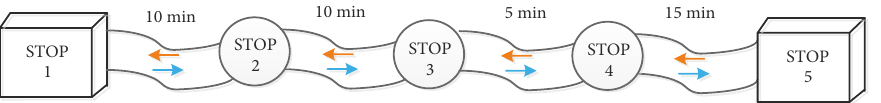
Figure 2. An example of bi-directional bus line